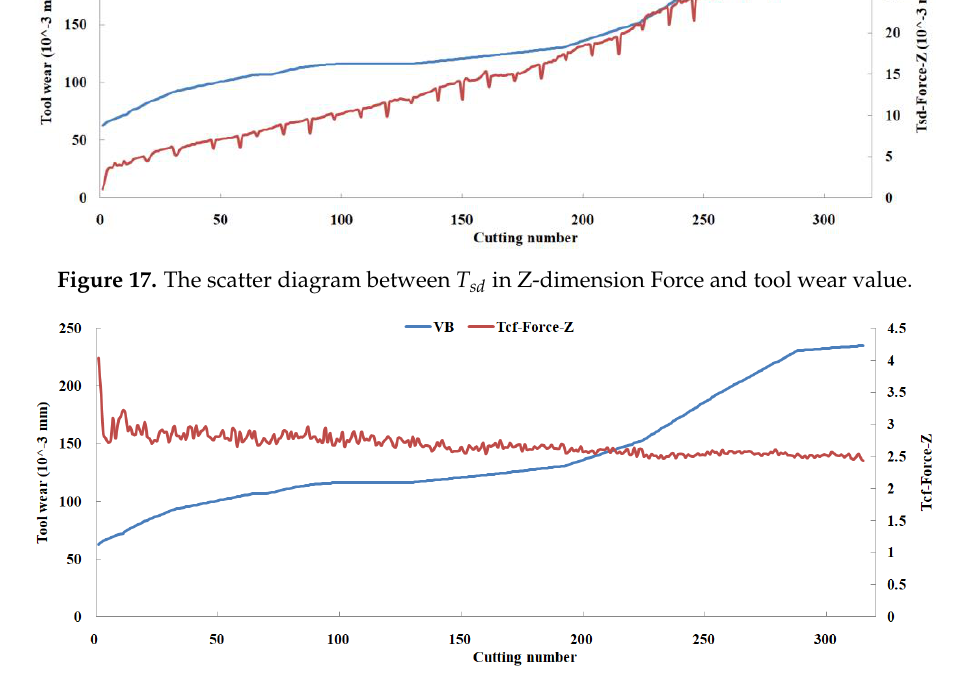
Figure 18. The scatter diagram between T cf in Z-dimension Force and tool wear value.